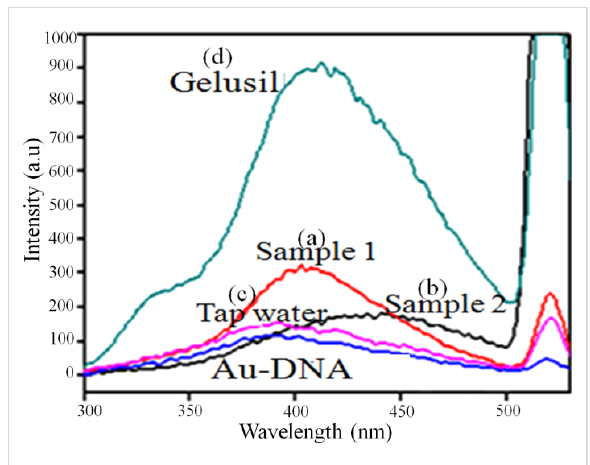
Figure 11: Fluorescence emission of an aqueous solution of Mg 2+ ions in Sample 1 (50 ppm), Sample 2 (150 ppm), tap water and an aqueous solution of gelusil (300 ppm) in comparison to bare Au–DNA nanocom- posite.